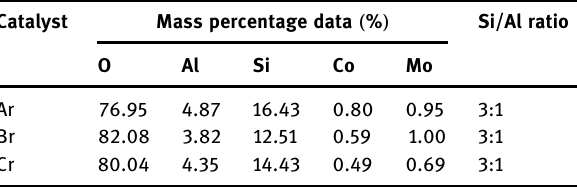
Table 3: The mass percentage data of the particles Catalyst